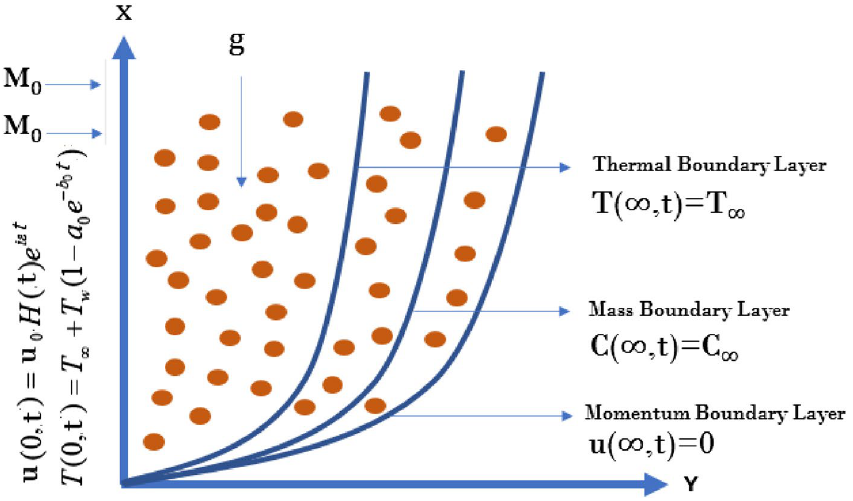
Figure 1. Physical geometry of the second grade fluid